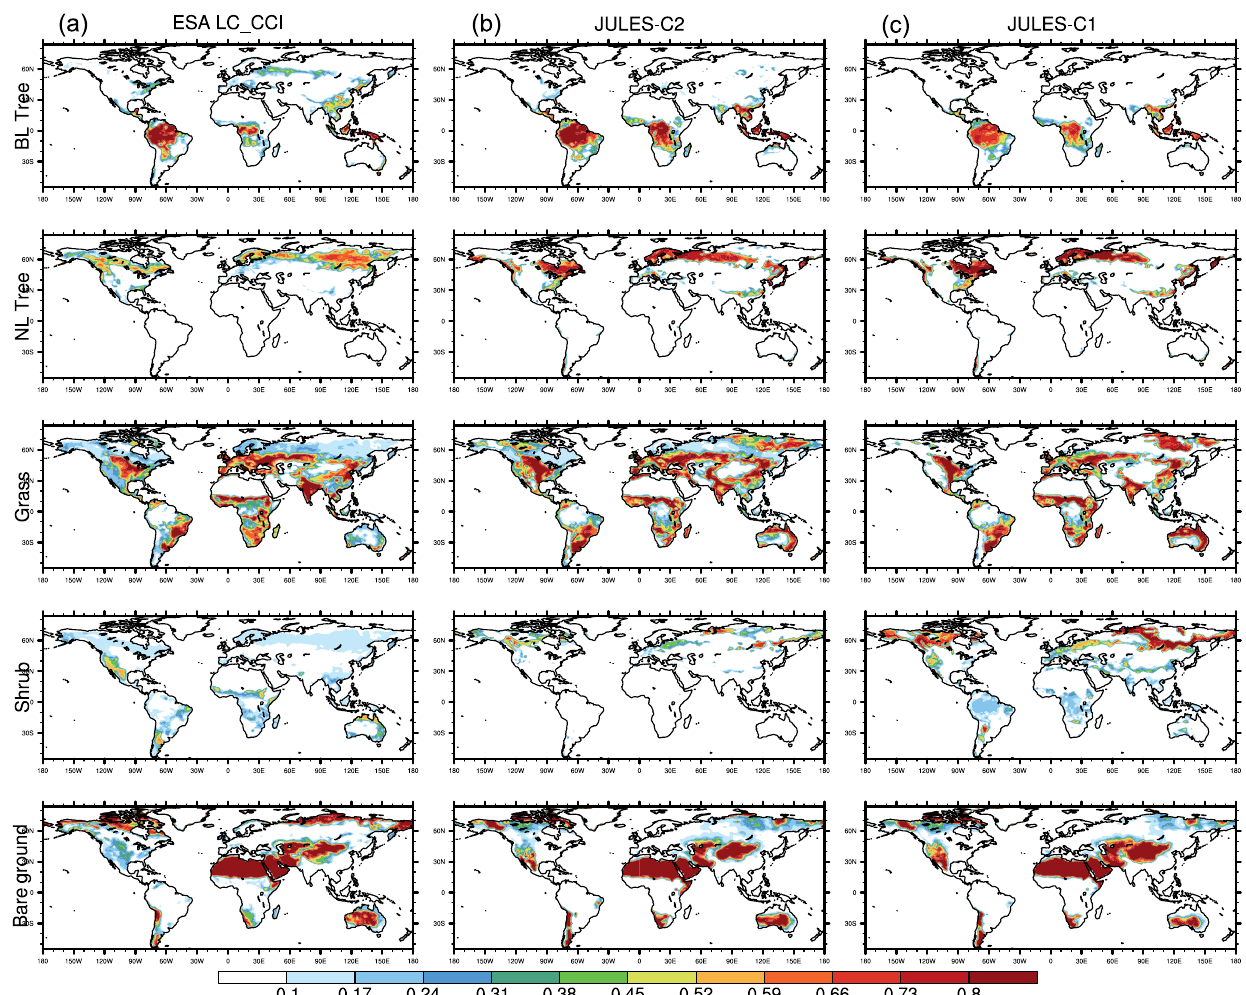
Figure 1. Fraction of land in each grid cell covered by vegetation and bare soil over the period 2010–2014 in the ESA LC-CCI dataset (a) , in JULES-C2 with CRUNCEP-v6 climate (b) , and in JULES-C1 with CRUNCEP-v6 climate (c) . BL represents broadleaf and NLrepresents